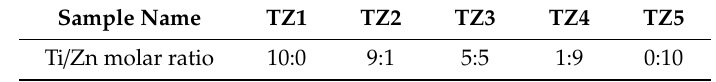
Figure 1. Schematic diagram of the multi-nozzle electrospinning process. Table 1. Sample names with the different Ti/Zn molar ratios of the electrospinning precursors.